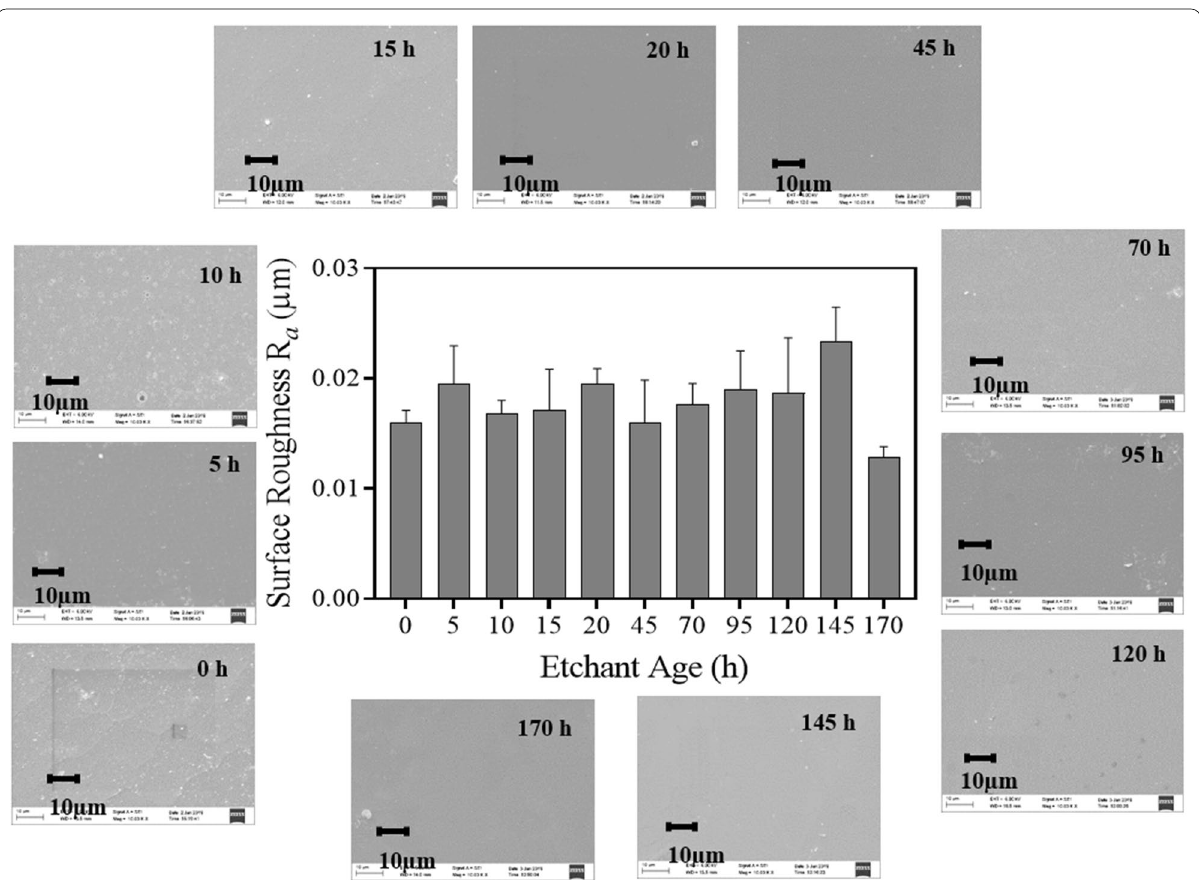
Fig. 47 Etched surface roughness (Ra) and corresponding surface morphologies of Si{111} etched in 10% NH 2 OH etchant age at 70 1 °C ±